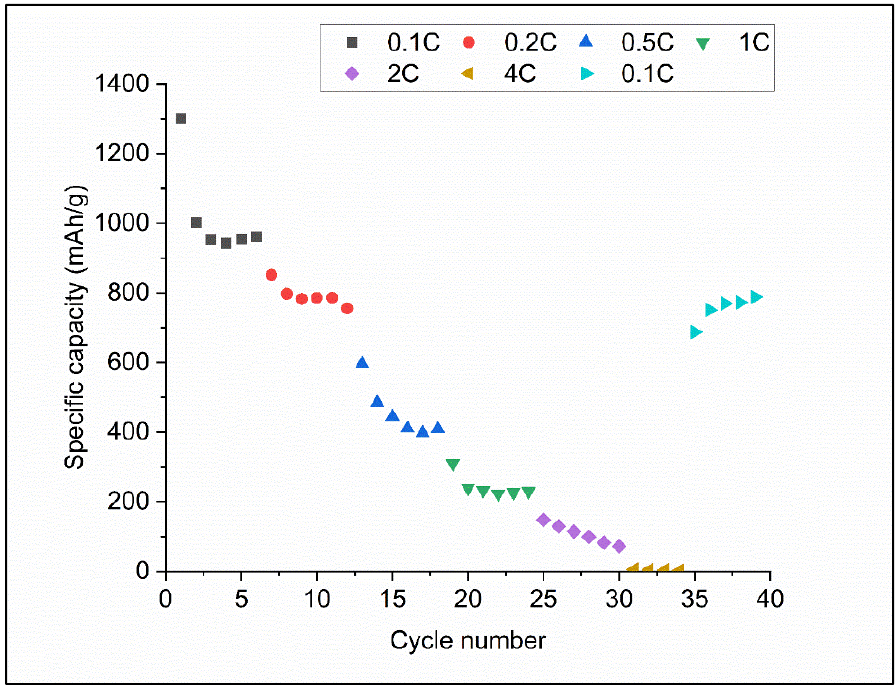
Figure 9. Rate capability of the SPNWL, Ni/W = 1:1 battery at 0.1, 0.2, 0.5, 1, 2, and 4 C-rates.